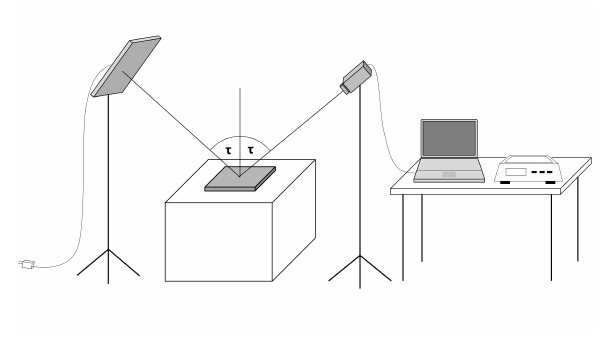
Figure 5. Experimental setup. A white LED spotlight illuminated a concrete specimen, the reflected light was captured with a polarization camera. The specimen was weighed in regular intervals, the camera was automized to capture and interpolate polarized images.